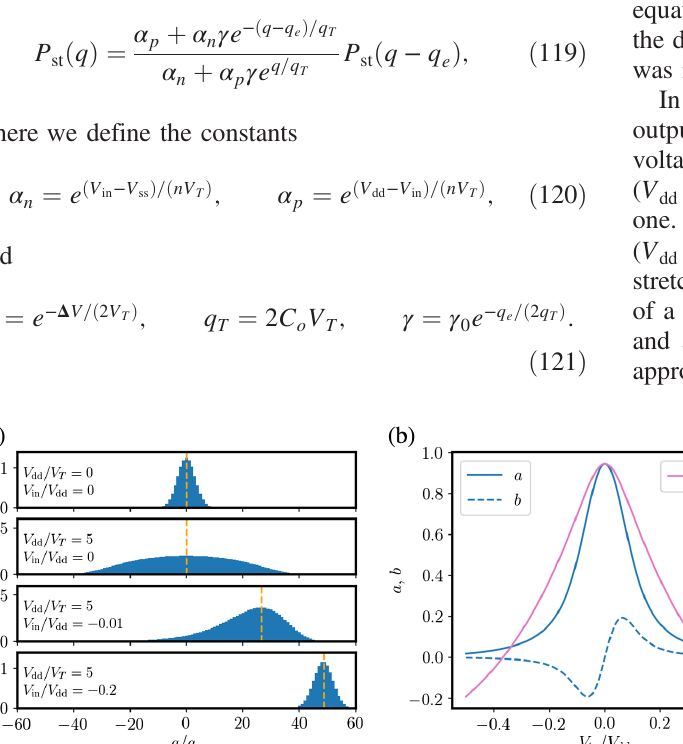
FIG. 11. (a) Probability distributions for the output charge of the inverter for different power and input voltages ( q − V and in the other numerical results, we consider V , so that Δ V ¼ 2 V . The dashed lines indicate the result of a deterministic ss ¼ dd dd analysis. (b) Parameters a and b quantifying the deviations of the fluctuations with respect to thermal equilibrium as a function of V 3 and q 0 . 5 ). We also show the average steady state current through the inverter (in units of q =V =q see Eq. (123) ( V T ¼ dd e T ¼ t 0 ¼ ð q =I 0 Þ exp ½ V = ð nV ). (c) Comparison of the transfer function obtained from a deterministic analysis and the exact one taking T Þ(cid:4) e th 3 and q 0 . 5 =V =q into account nonequilibrium fluctuations ( V T ¼ e T ¼ dd